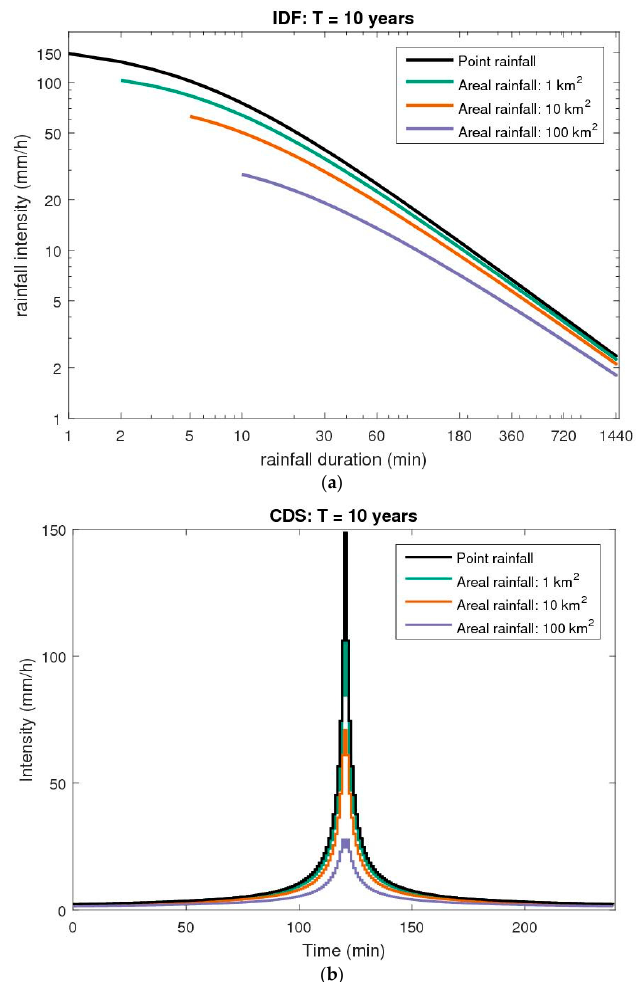
Figure 9. Example of intensity–duration–frequency curves ( a ) and Chicago design storms ( b ) with a return period of 10 years [2] adjusted with the developed mean aerial reduction factors.